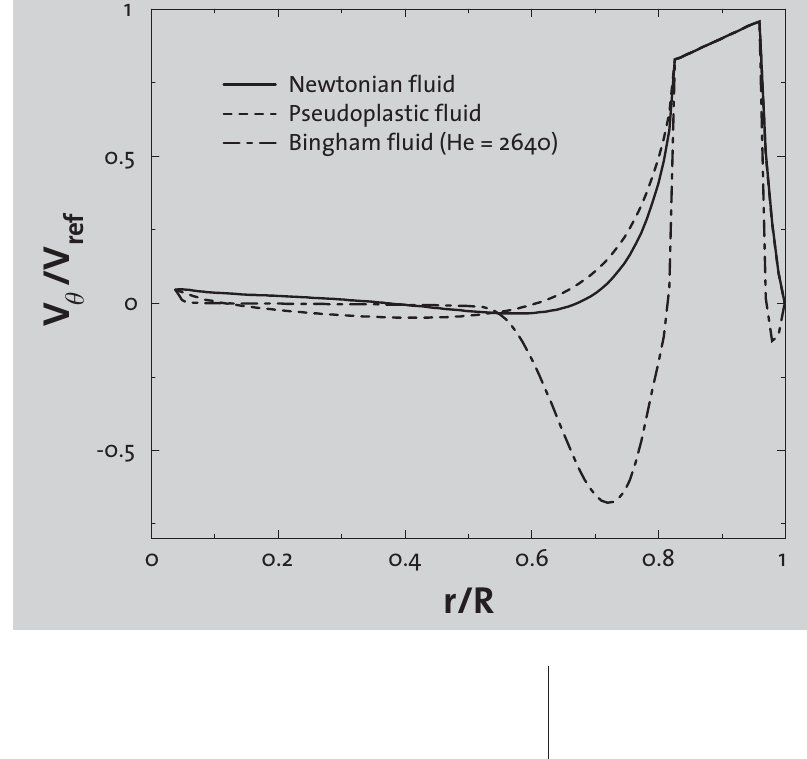
Figure 5 (below):Tangential velocity on the impeller plane